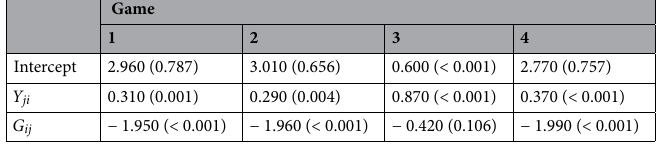
Table 3. Coefficients for the additive effects models. p values are in brackets next to the